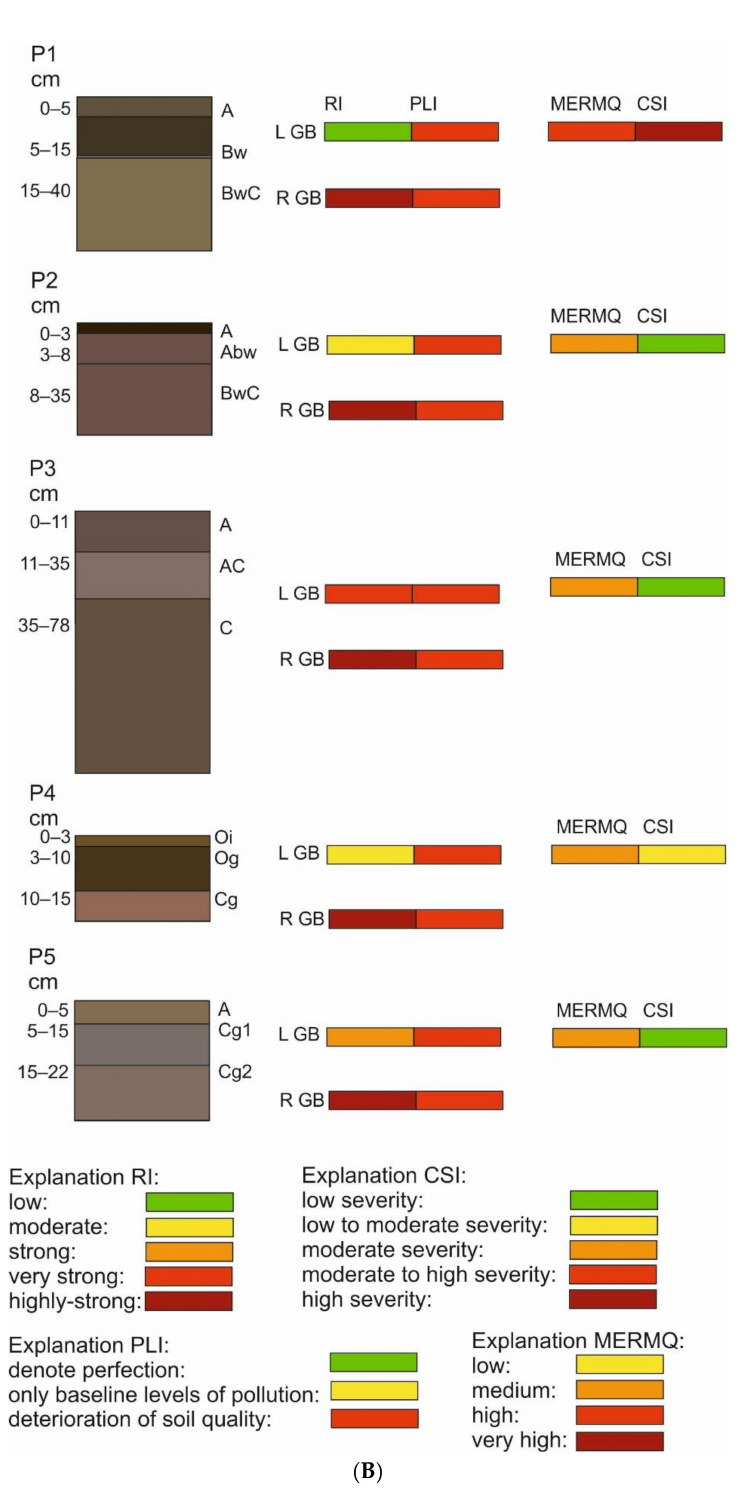
Figure 4. ( A ). The degree of contamination based on pollution indices’ values. Explanation: pollution indices calculated based on: L GB—local geochemical background; R GB—reference geochemical background; I geo —Geochemical Index; EF—Enrichment Factor; RI—Potential Ecological Risk. ( B ) The degree of contamination based on pollution indices’ values. Explanation: pollution indices calculated based on: L GB—local geochemical background; R GB—reference geochemical background; RI— Potential Ecological Risk; PLI—Pollution Load Index; MERMQ—The Probability of Toxicity; CSI— Contamination Security